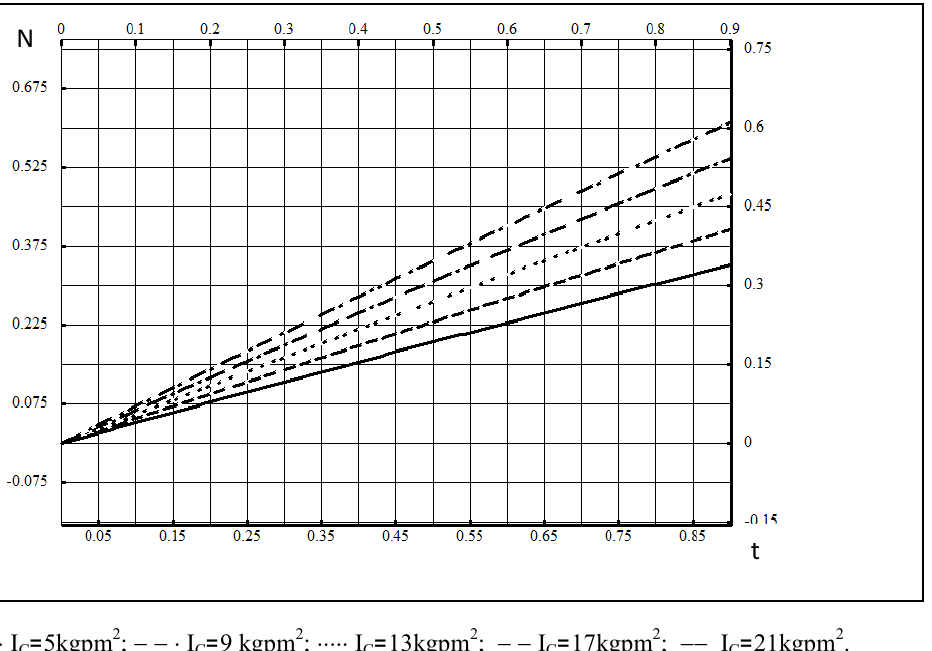
Fig. 5. Characteristic curves of masses center trajectory for different body masses center height values